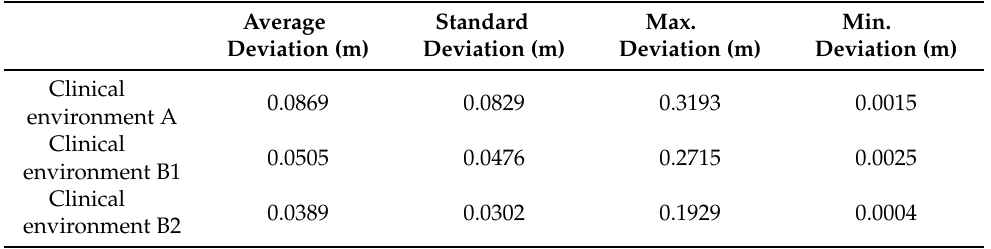
Table 5. Robot’s deviation from the global plan (the planned trajectory) in clinical